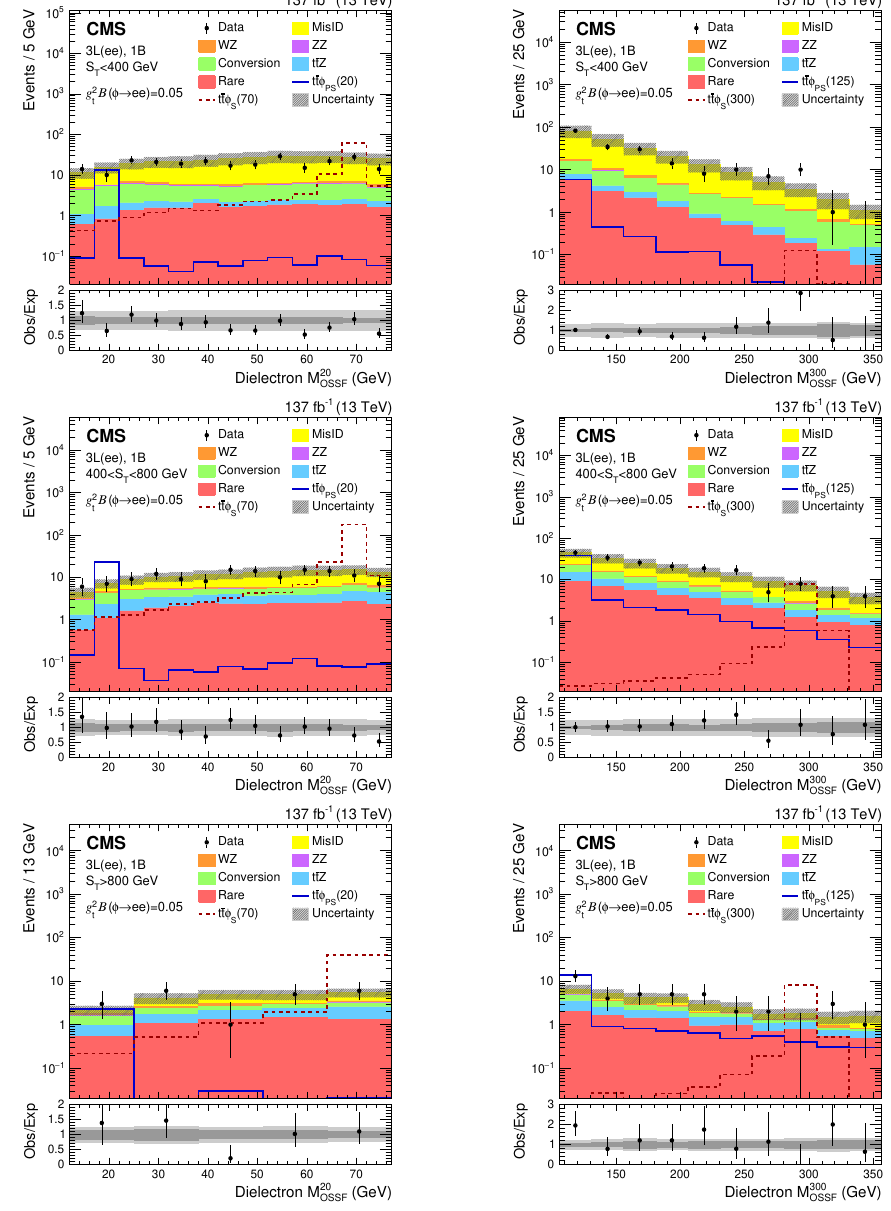
Figure 6 . Dielectron M 20 (left column) and M 300 (right column) distributions in the 3L(ee) OSSF OSSF 1B tt (cid:30) signal regions. Upper, center, and lower plots are for S < 400 GeV, 400 < S < 800 GeV, T T and S > 800 GeV, respectively. The total SM background is shown as a stacked histogram of all T contributing processes. The predictions for tt (cid:30) ( ! ee) models with a pseudoscalar (scalar) (cid:30) of 20 B ( (cid:30) ! ee) = 0 : 05 are also shown. The lower panels and 125 (70 and 300) GeV mass assuming g 2 t show the ratio of observed to expected events. The hatched gray bands in the upper panels and the light gray bands in the lower panels represent the total (systematic and statistical) uncertainty of the backgrounds in each bin, whereas the dark gray bands in the lower panels represent only the statistical uncertainty of the backgrounds. The rightmost bins do not contain the over(cid:13)ow events as these are outside the probed mass